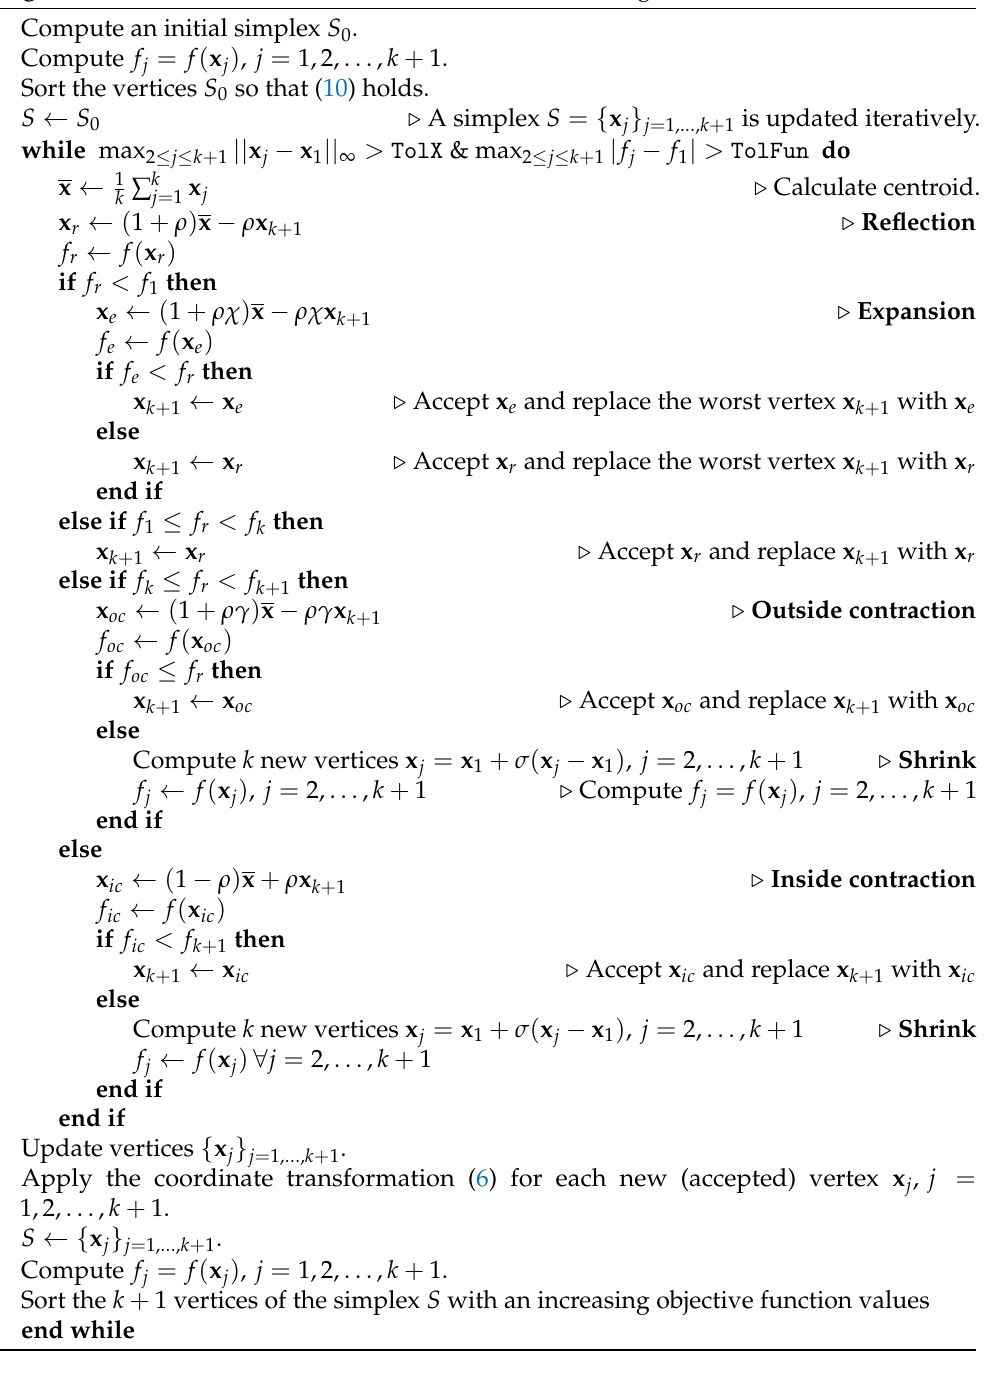
Algorithm 1 One iteration of the standard Nelder-Mead